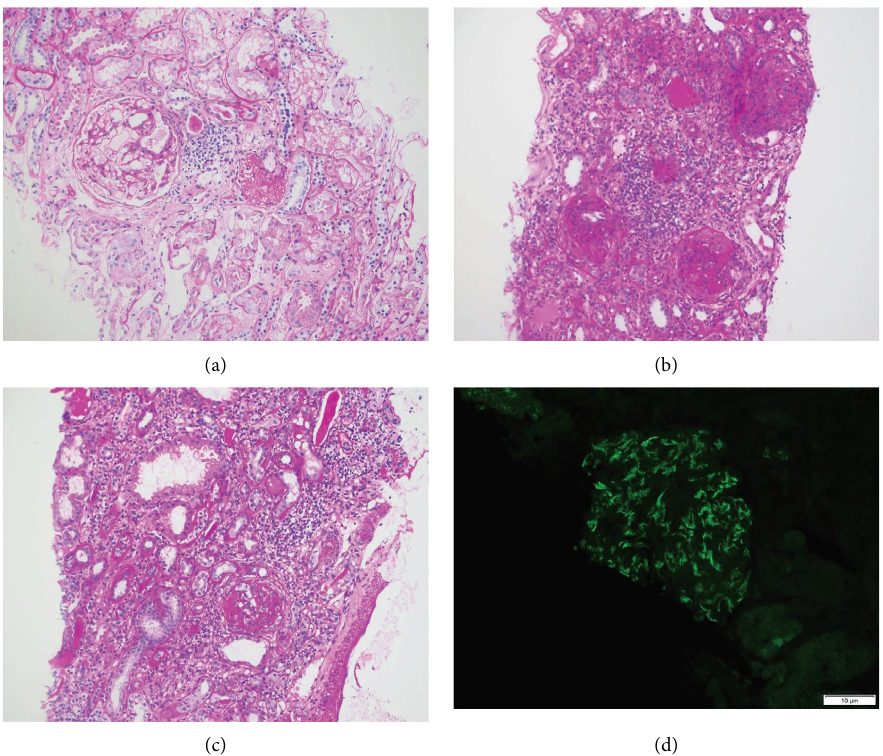
Figure 1: Severity of tubulointerstitial infammation (periodic acid Schif stain) and IgA immunofuorescence, 10x. Mild infammation (a), moderate infammation (b), severe infammation (c), and IgA immunofuorescence, mesangial staining